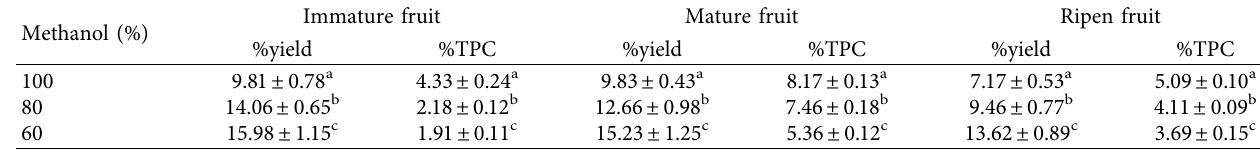
Table 1: Extract yield and total PC of different percent methanol extract of BG fruit at different growth stages. Methanol